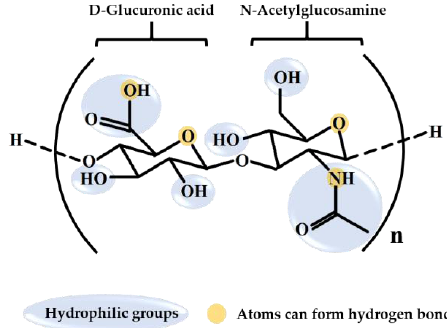
Figure 1. Chemical structure of hyaluronic acid.